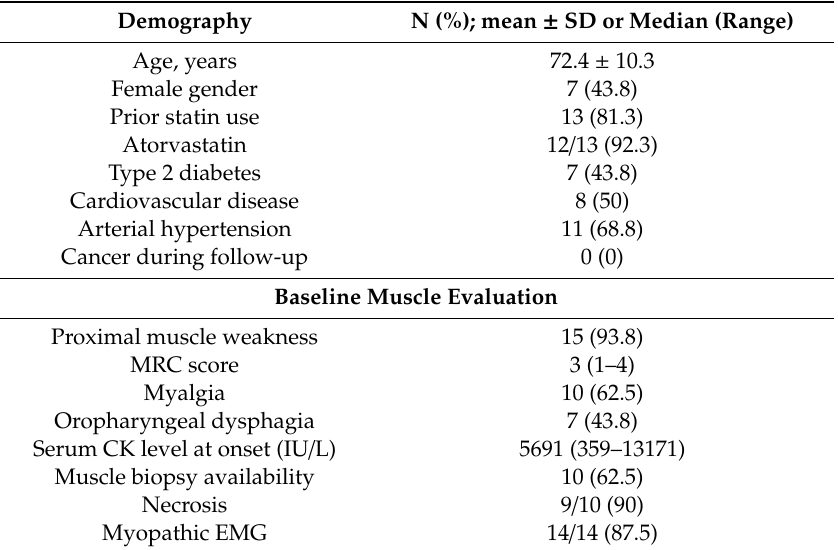
Table 2. Baseline characteristics of the patients with anti-HMGCR myopathy ( n = 16).